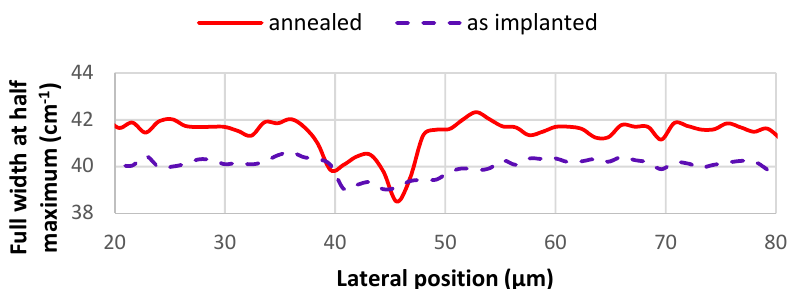
Figure 14. Full width at half maximum of the 922.3 cm − 1 Raman line across an as-implanted (dashed line) channel waveguide, irradiated with a carbon microbeam of E = 11 MeV at a fluence of 4.16 · 10 15 ion/cm 2 , and a thermally annealed (continuous line) channel waveguide, irradiated with a carbon microbeam of E = 11 MeV at a fluence of 4.6 × 10 15 ion/cm 2 . Note that the widths of the two channel waveguides are different [40].